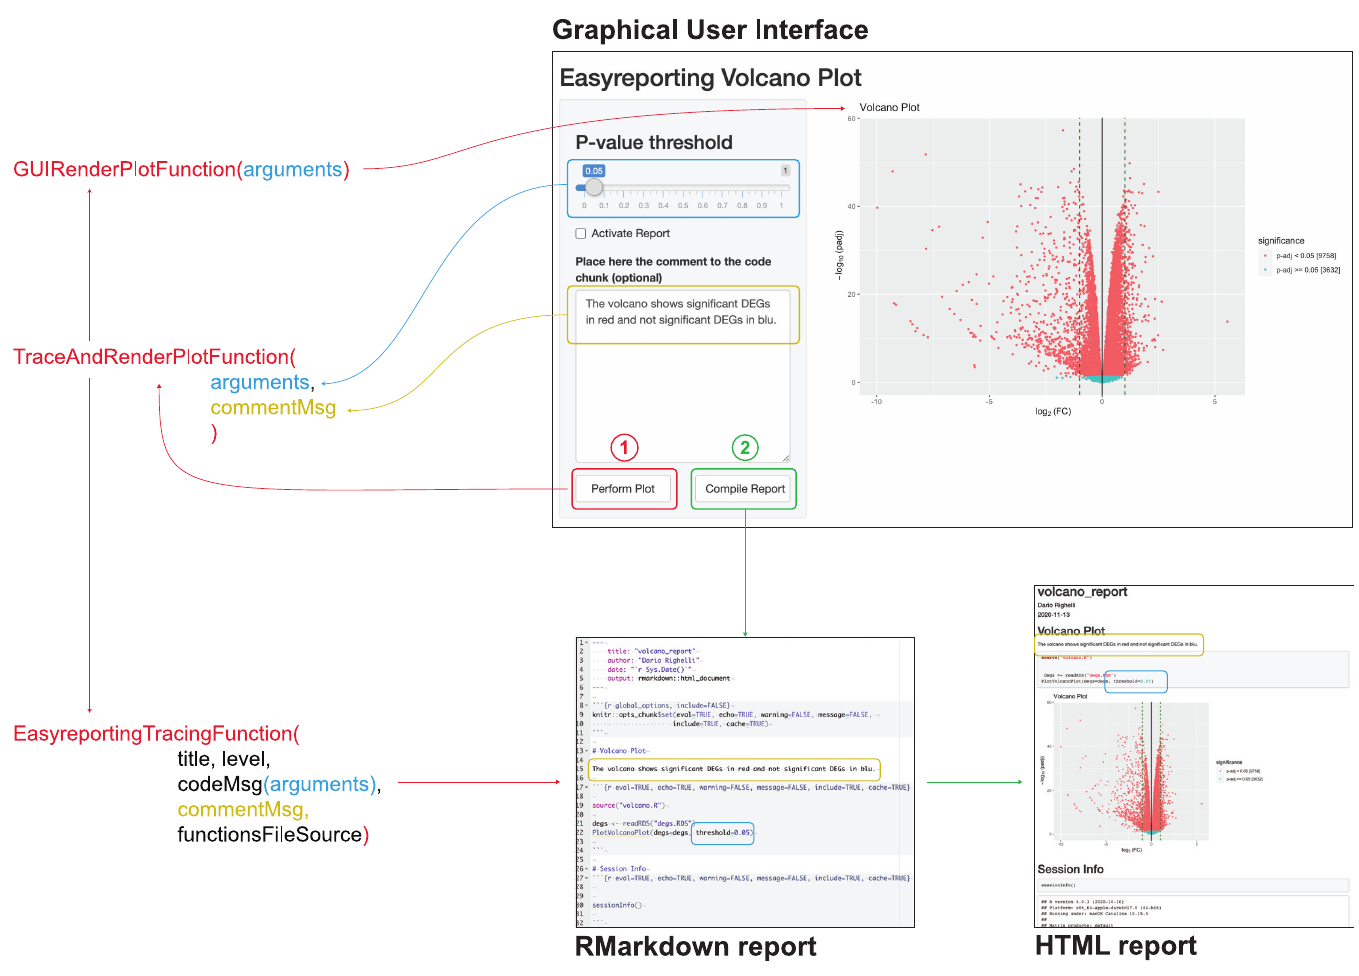
Fig 2. Example of a graphical user interface working with easyreporting